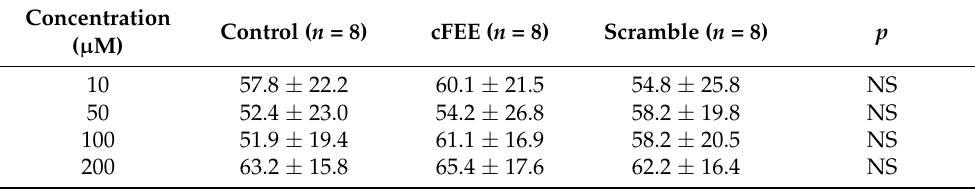
Table 2. cFEE does not affect sperm